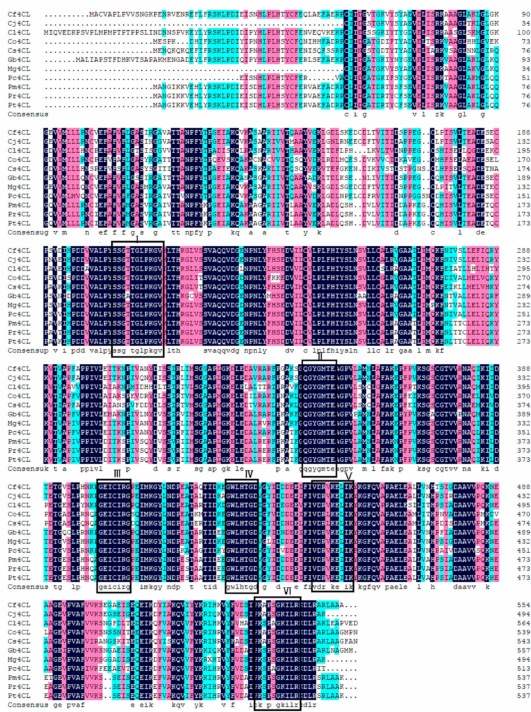
Figure 2. Multiple sequence alignment of the 4CL protein using 10 plant species. The species represented by the abbreviations on the left side of the figure and their registration numbers in NCBI are as follows: Cf4CL ( C. fortunei , MK236392), Cj4CL ( C. japonica , AFJ73433.1), Mg4CL ( Metasequoia glyptostroboides , AFJ73430.1), Pc4CL ( Pseudotaxus chienii , AFJ73459.1), Gb4CL ( Ginkgo biloba , AMN10098.1), Pm4CL ( Pinus massoniana , ACO40513.1), Pt4CL ( P. taeda , AAA92669.1), Pr4CL ( P. radiate , ACF35279.1), Cl4CL ( Cunninghamia lanceolate , AFX98059.1), Co4CL ( Cinnamomum osmophloeum , AFG26323.1),